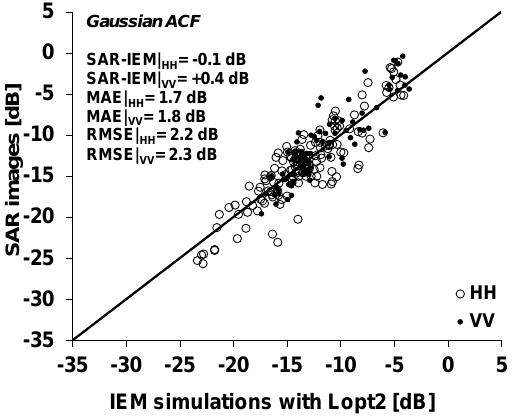
Figure 8. Validation of the semi-empirical calibration approach in using the fitting parameter Lopt2 . Mean of the difference between SAR and IEM and root mean square error were